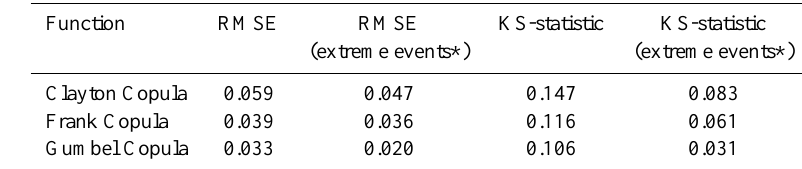
Table 3. RMSEs and values for the KS-statistic from comparing theoretical and empirical trivariate joint probabilities ( S , F and H s ) for